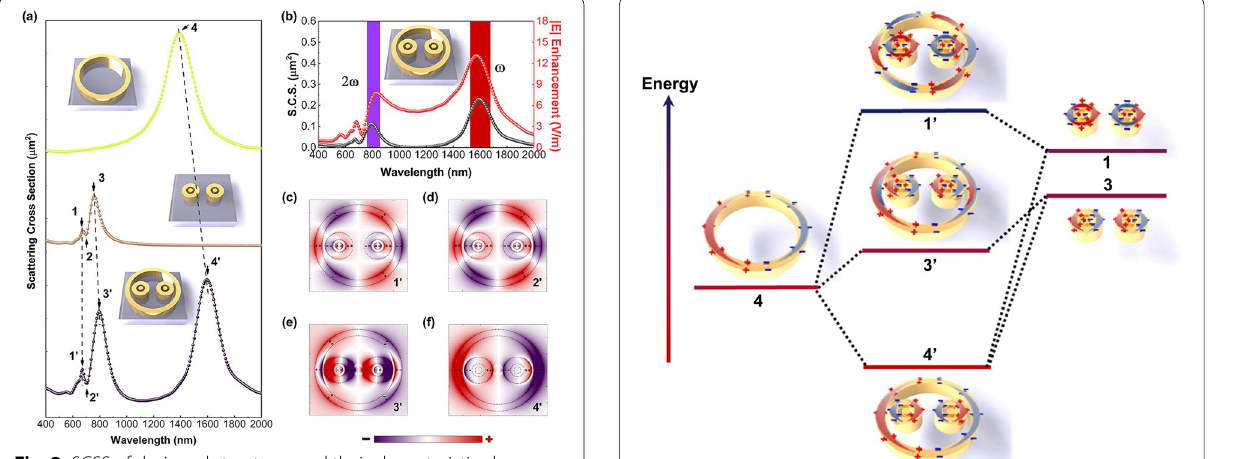
Fig. 2 SCSS of designed structures and their characteristic charge distributions. a SCSS of a wall ring, paired bull-eye rings, and the hybrid metasurface. Insets are the schematics of simulated structures. b SCSS (gray line) of the hybrid metasurface and the near-field enhancement (red line) at the center. The spectrum shows a simultaneous pronounced over-lap with the fundamental and SHG wavelengths, which are marked by red and purple stripes. The inset shows a unit of the hybrid metasurface. c – f Charge distributions at featured peaks of 1 ′ –4 ′